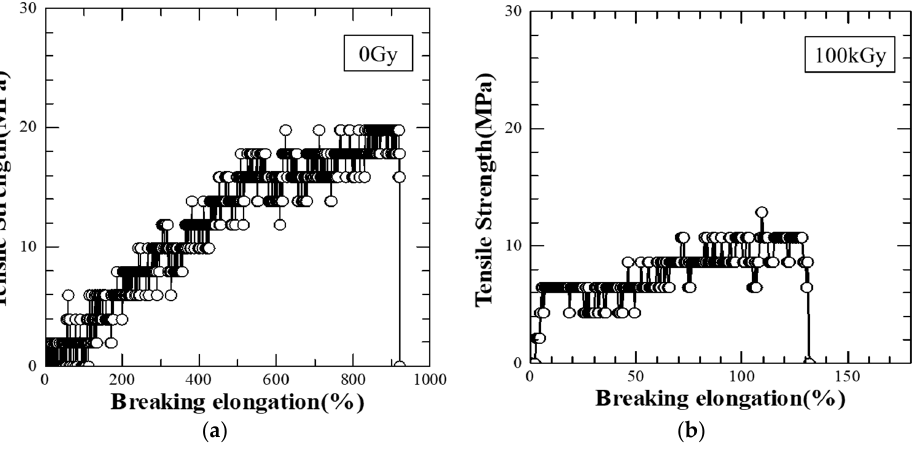
Figure 13. Stress ‐ elongation graph of PLA ‐ 80 (( a ) 0 Gy and ( b ) 100 kGy). Table 3. Average values of tensile strengths at breaking, breaking elongations and Young’s modulus were obtained from the stress ‐ strain diagram of irradiated PLA ‐ 80.